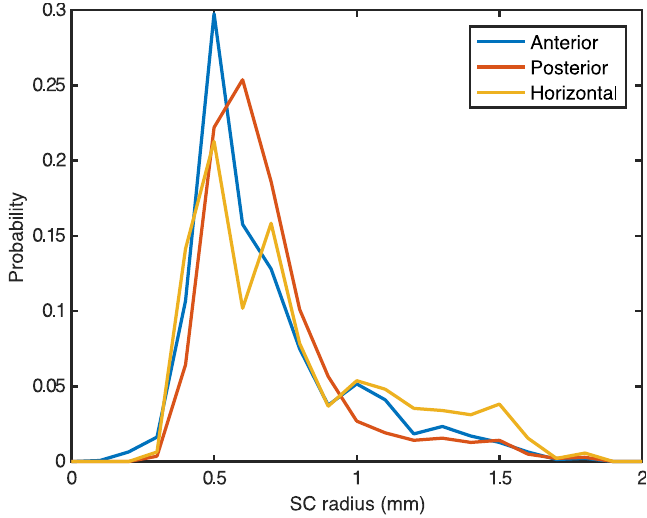
Figure 5. SCs’ radii histogram for each